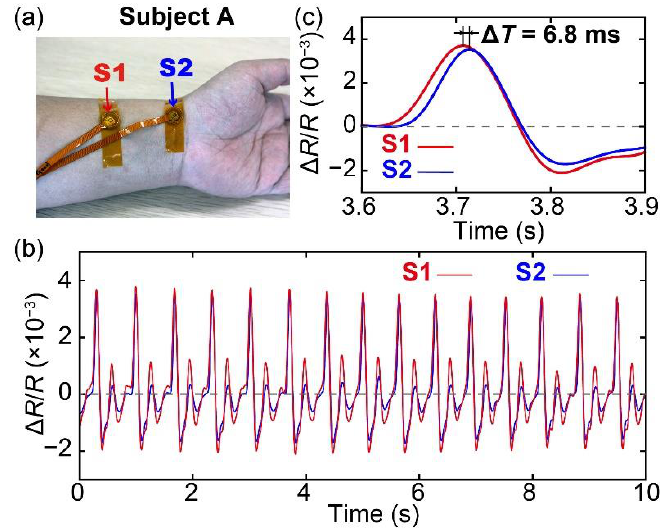
Figure 6. ( a ) Photograph of the two sensors placed at two points on the wrist of the subject to measure the pulse wave velocity. ( b ) Pulse waves measured using sensors S1 and S2. ( c ) Zoomed-in view of the pulse wave measured using the two sensors.